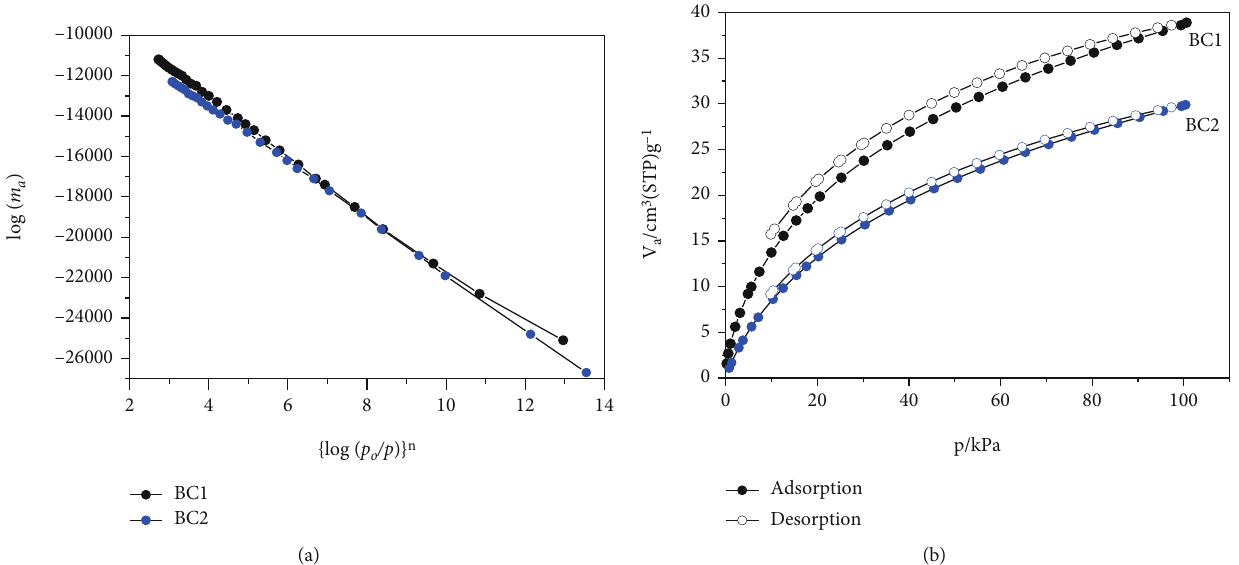
Figure 11: DA-plot (a) and adsorption/desorption isotherm (b) of BC1 and BC2 in CO